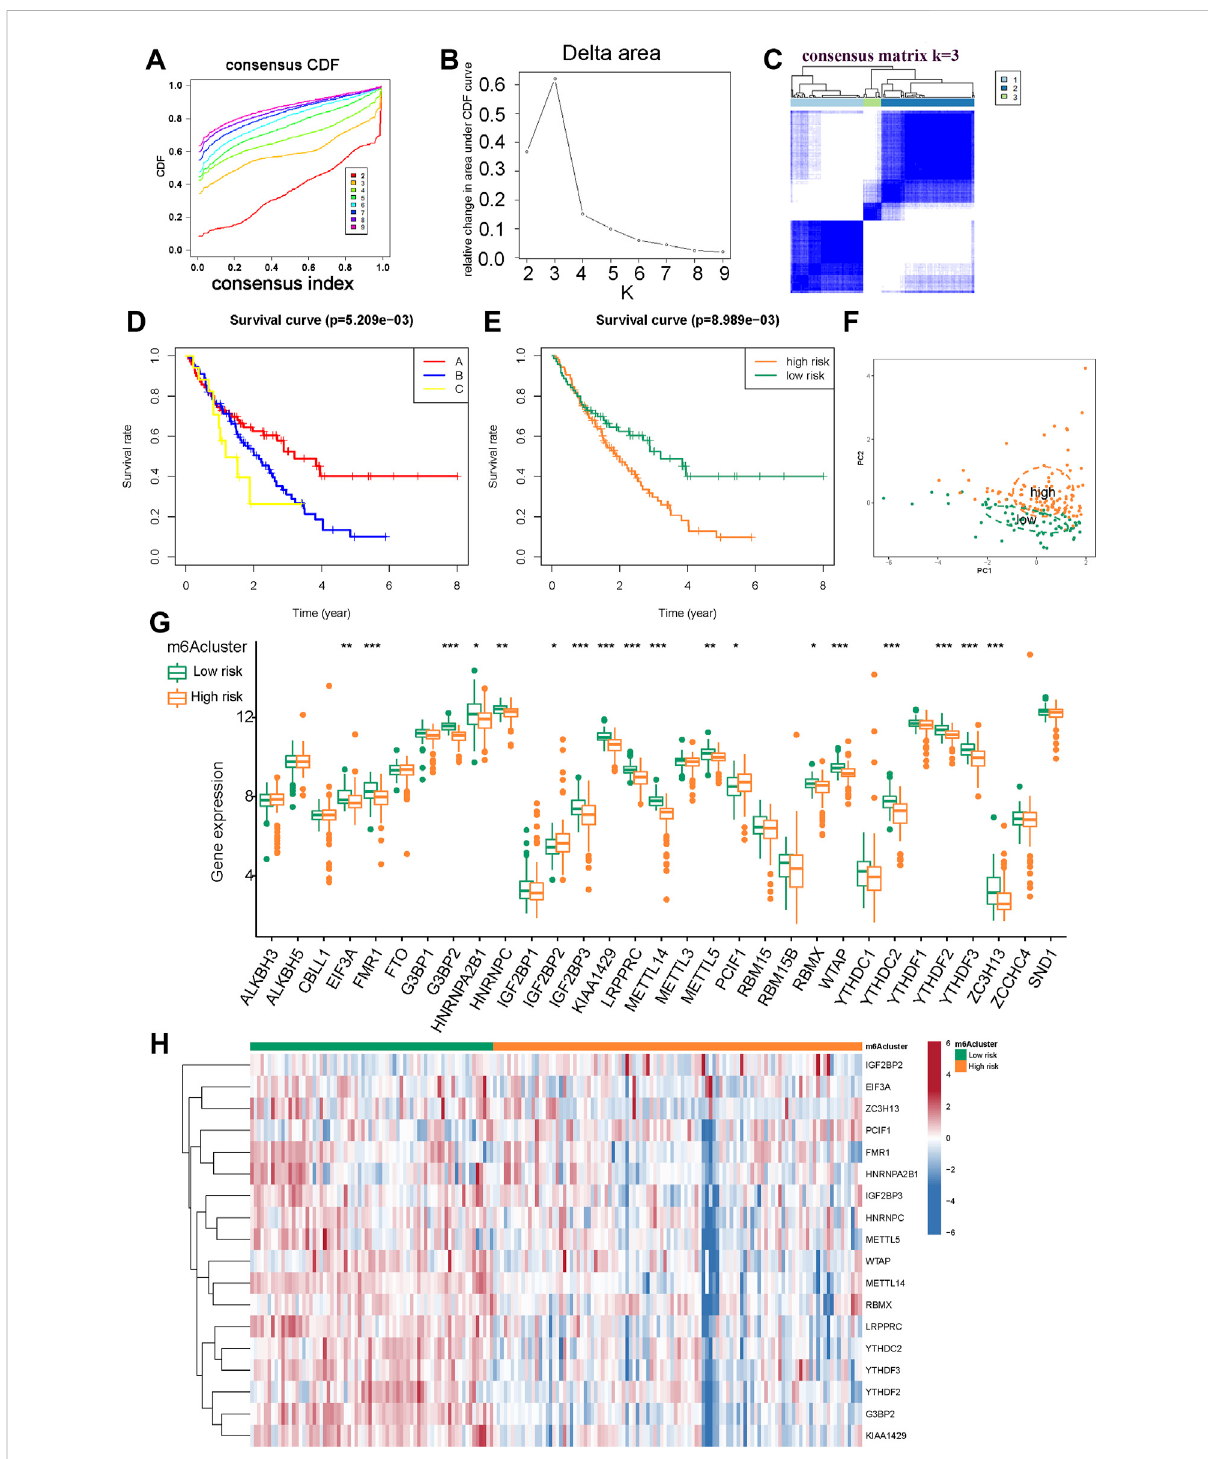
FIGURE 4 Consensus clustering of prognosis-related m6A modulators in IPF. (A) The CDF plot. (B) The relative change in area under the CDF curve. (C) Consensus matrixes of the two signi fi cant m6A regulators ( METTL14 and G3BP2 ) for k = 3. (D) Kaplan-Meier plot of overall survival in different m6A clusters. (E) Kaplan-Meier plot of overall survival in m6A low-risk (cluster A) and m6A high-risk (cluster B and C). (F) PCA for m6A low-risk and high- risk. (G) Histogram of 31 m6A regulators in m6A low-risk and m6A high-risk. (H) Expression heatmap of 18 differentially expressed m6A regulators in m6A low-risk and